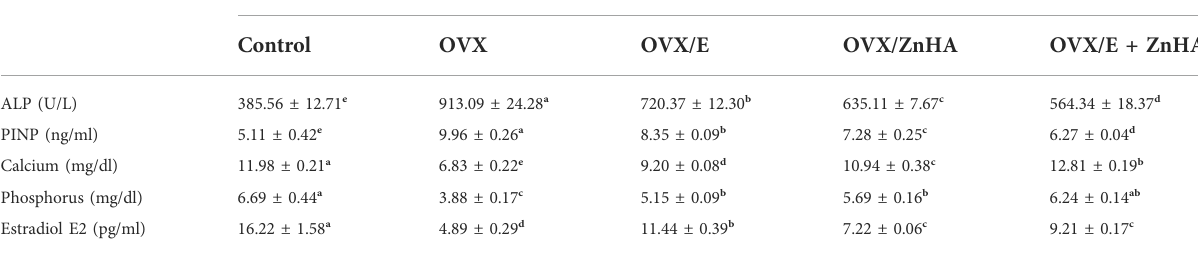
TABLE 2 Effects of estrogen (E2) and zinc hydroxyapatite (ZnHA) treatments on concentrations of serum bone turnover markers of control and treated rats. Parameters